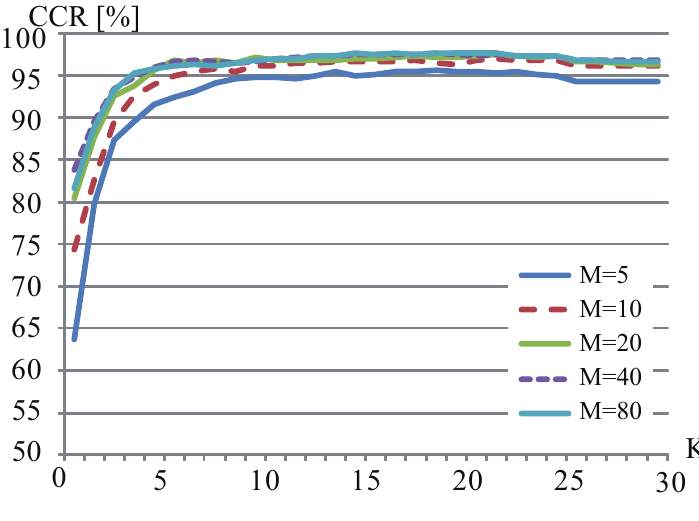
Figure 6. Correct classification rates by the proposed method